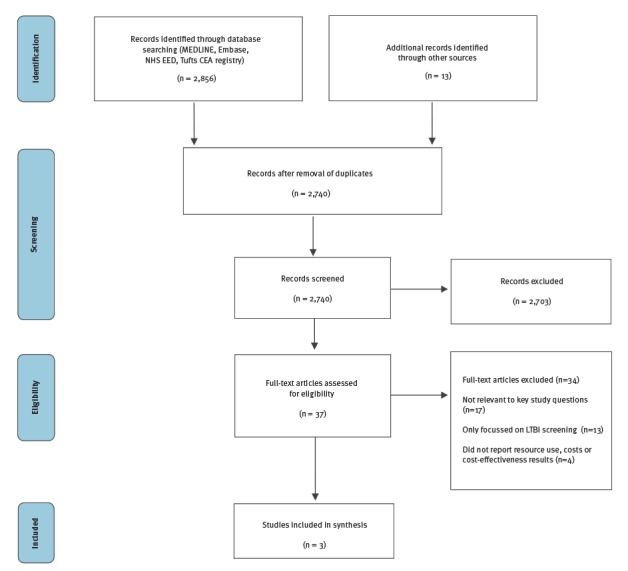
PRISMA flow diagram, literature search for the resource use, costs and cost-effectiveness of active tuberculosis screening, 1 January 2000–31 May 2016